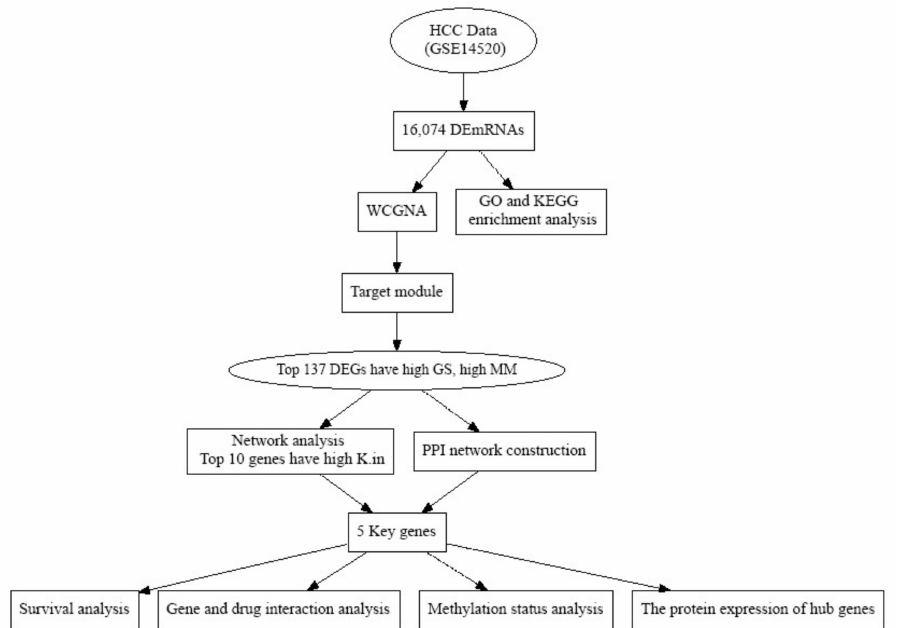
Figure 1. The flow chart of data collection, processing, analysis, and validation. HCC: hepatocellular carcinoma; DEmRNAs: differentially expressed mRNAs; PPI: protein–protein interaction; GSE: gene expression data; GO: gene ontology; KEGG: Kyoto Encyclopedia of Genes and Genomes; WGCNA: weight gene co-expression network analysis; MM: module membership; GS: gene significant; K.in: intramodular